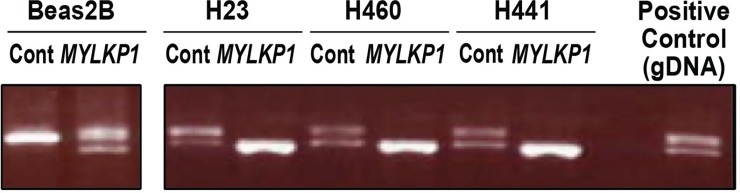
Simultaneous detection of MYLK and MYLKP via PCR in non-cancer cells (beas2b) and cancer cells (H23, H460, and H441).